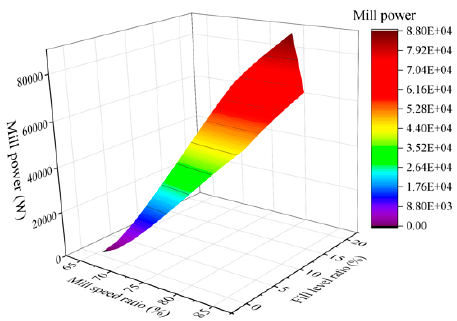
Figure 9. Mill power of mixed parameter.